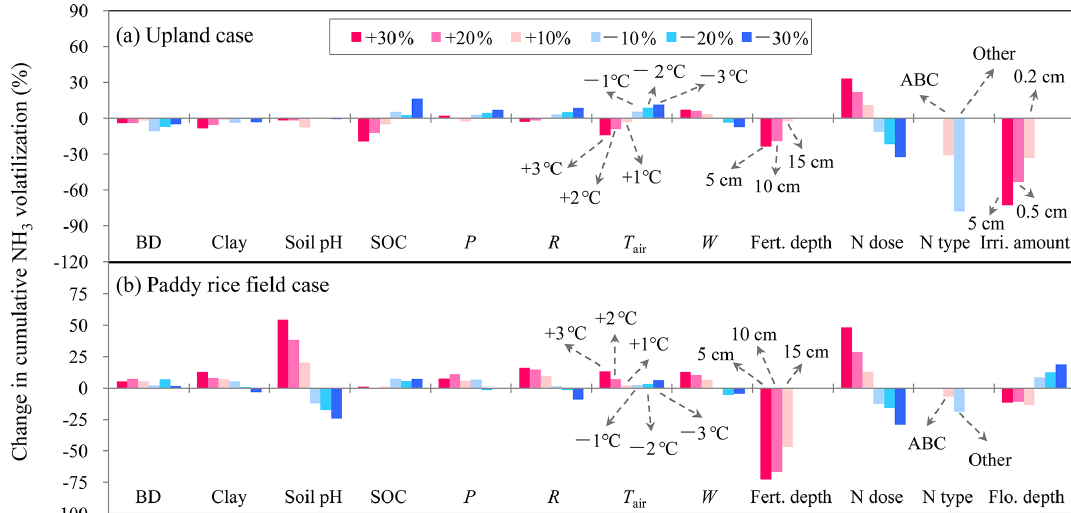
Figure 7. Sensitivity analysis of the modified CNMM–DNDC in simulating cumulative ammonia (NH 3 ) volatilization from uplands and rice paddy fields during the measurement periods through change input factors. The investigated input factors include 3-hourly averages of air temperature ( T air ) and wind speed ( W ); 3-hourly totals of precipitation ( P ) and solar radiation ( R ) during individual measurement periods of NH 3 volatilization; soil clay fraction, pH, organic carbon (SOC) content and bulk density (BD); irrigation water amount (Irri. amount) and floodwater depth (Flo. depth); and nitrogen fertilization depth, dose, and type (Fert. depth, N dose, and N type, respectively). The N types include ammonium bicarbonate (ABC) and other ammonium-based nitrogen fertilizers (Other). The legends within the frame apply to all the subfigures and all the factors without notes highlighted by